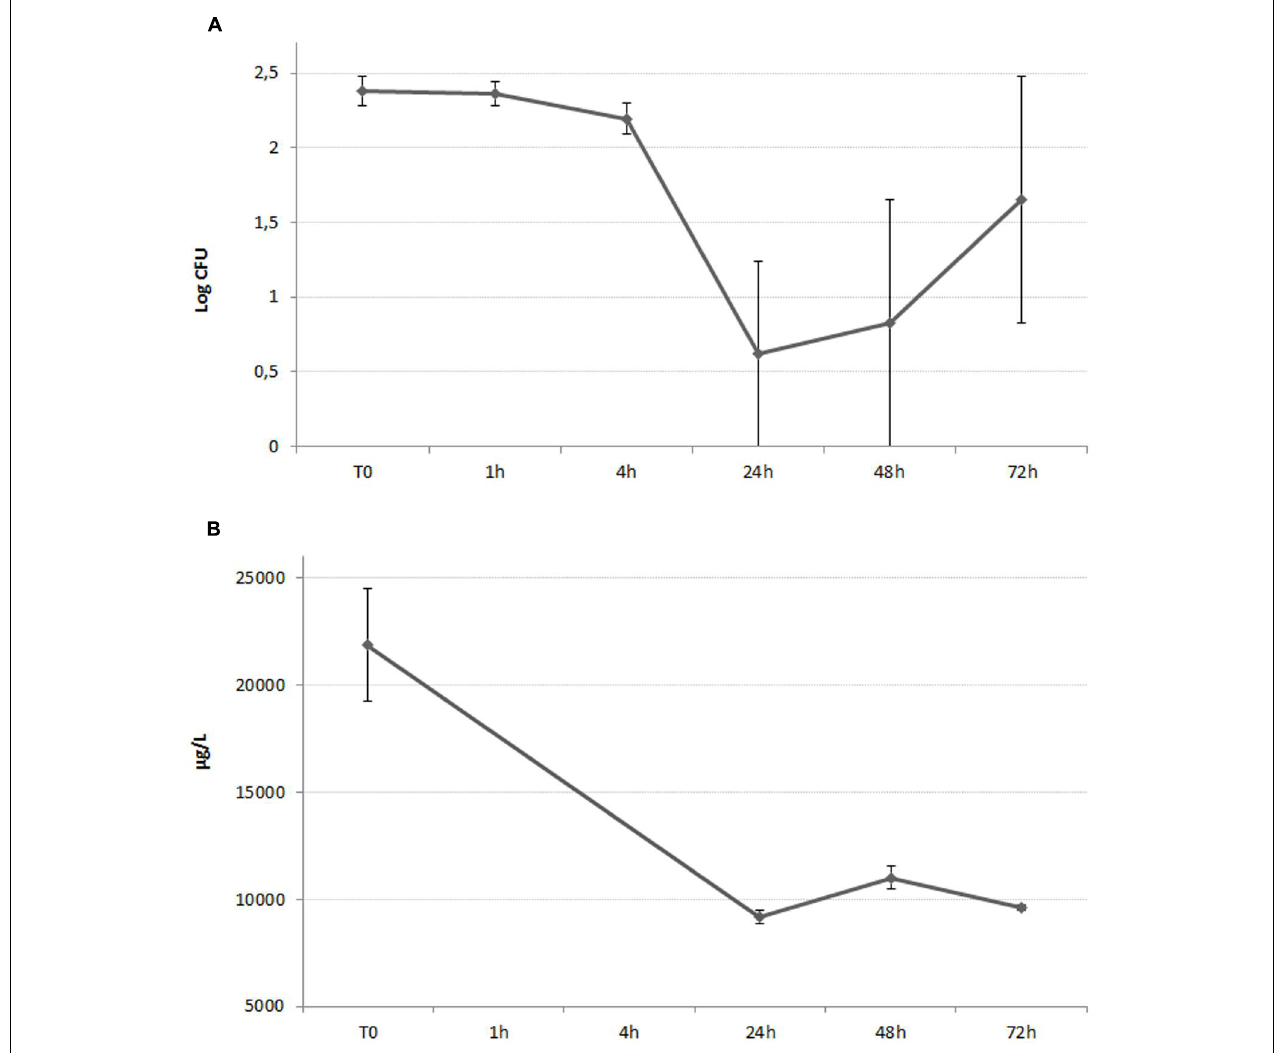
FIGURE 4 | (A) Growth curve of L. monocytogenes in the presence of AgNO 3 , 30 ppm. The graphed values represents the mean of the counts belonging to Listeria monocytogenes strain n ◦ 5. (B) Time course assay of the silver ionic release of a 30 ppm solution of AgNO 3 , incubated in the presence of L. monocytogenes isolate